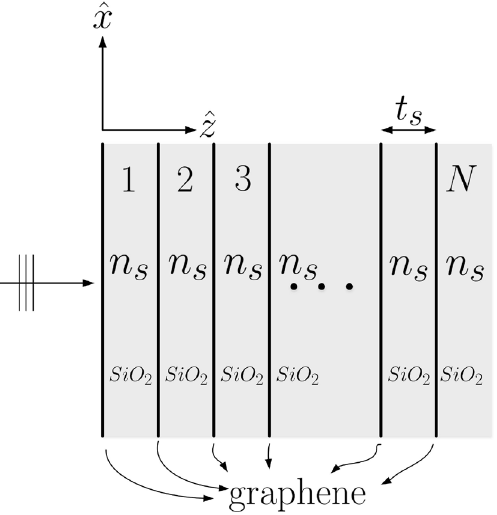
Figure 1. Structure configuration of a stratified graphene-dielectric